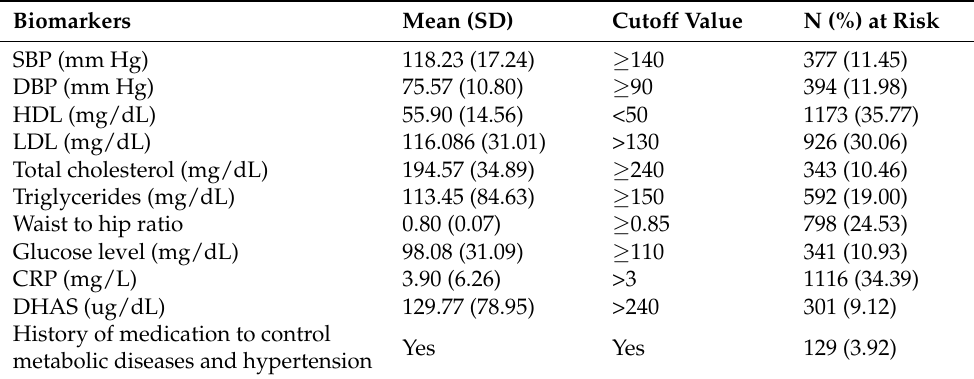
Table 1. Distribution and high-risk cutoff points for individual biomarkers of AL scores *.